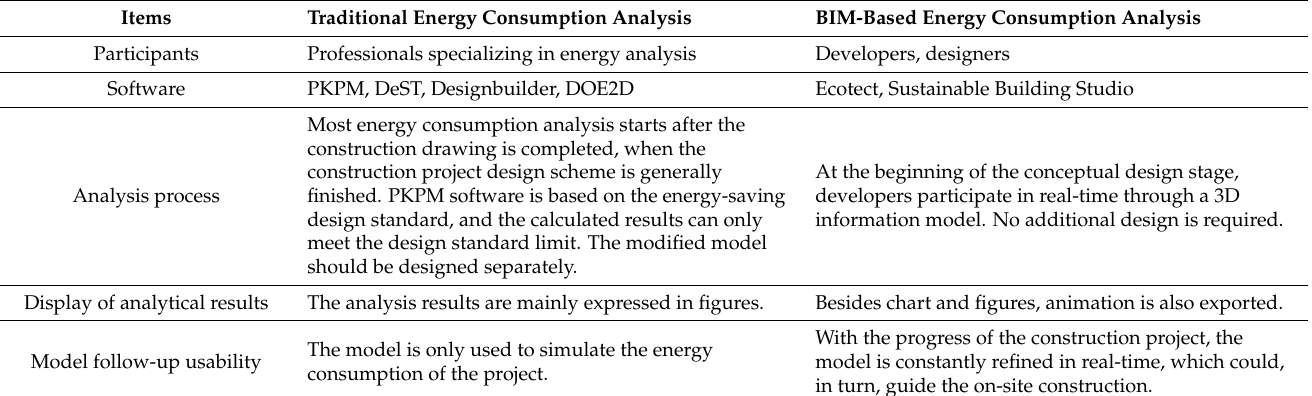
Table 4. Comparison between traditional and BIM-based energy consumption